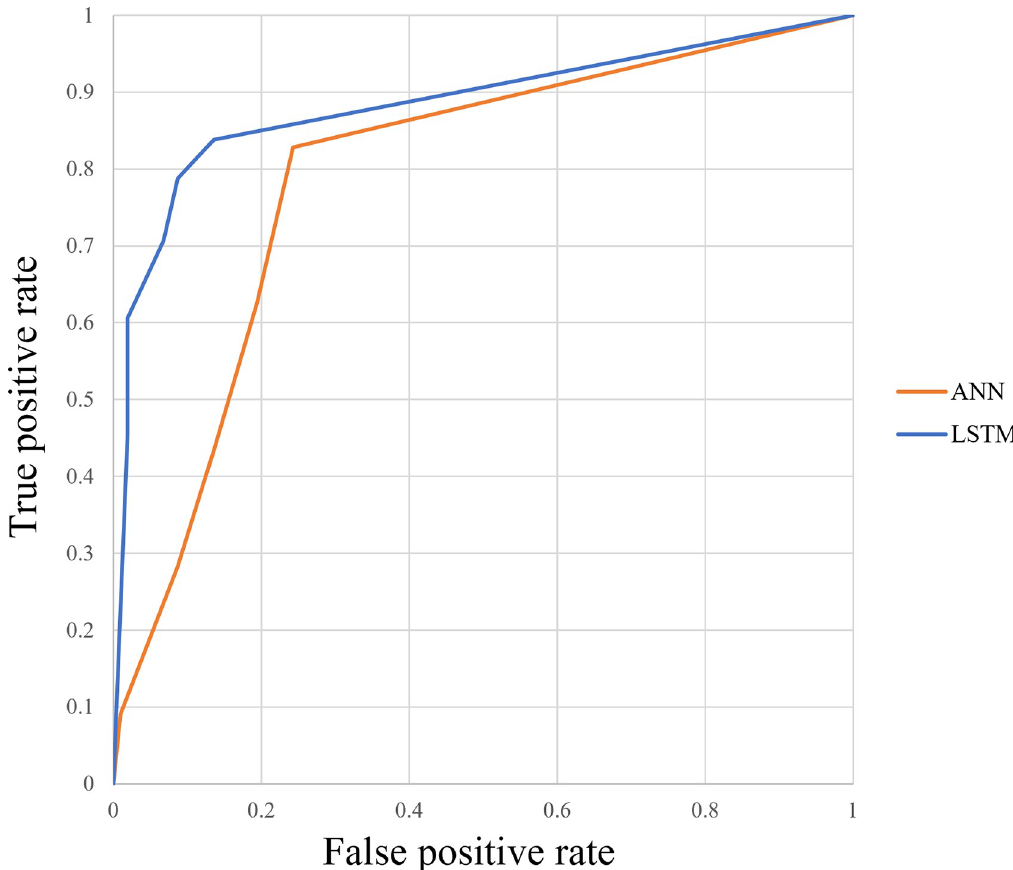
Fig 14. ROC curves of the LSTM versus ANN in short-axis papillary muscle